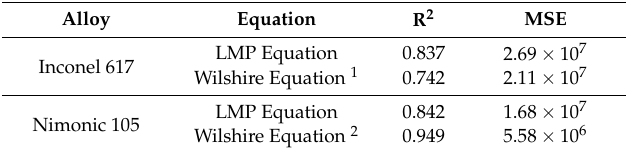
Table 10. Goodness of fit and error of Wilshire and LMP calculations.